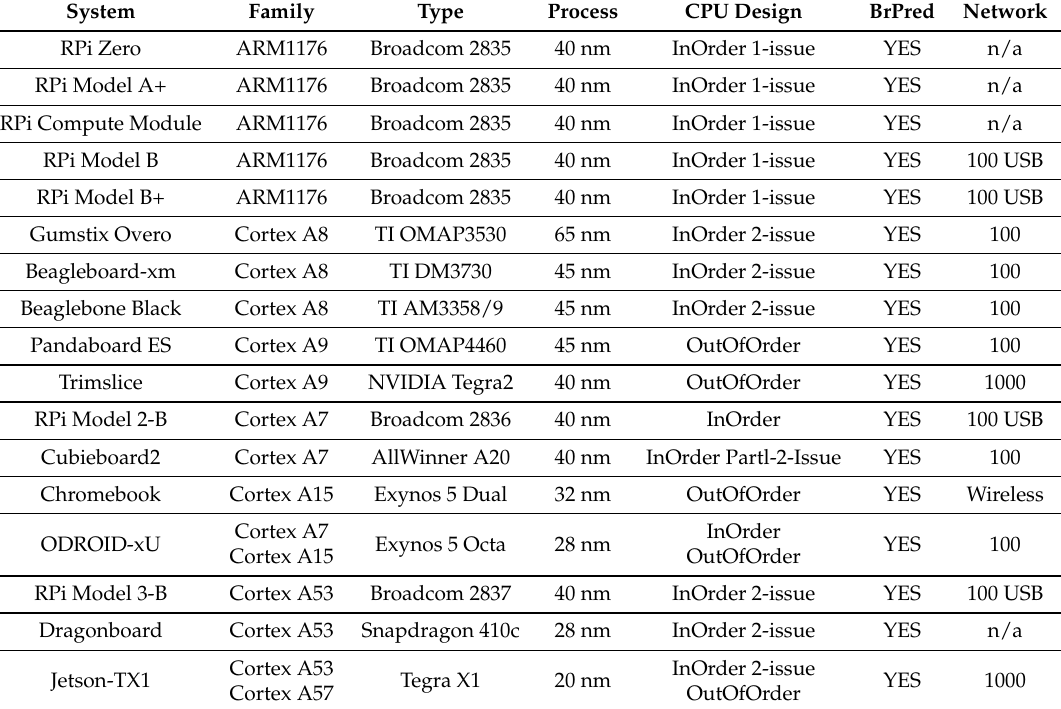
Table A1. Overview of the ARM systems examined in this